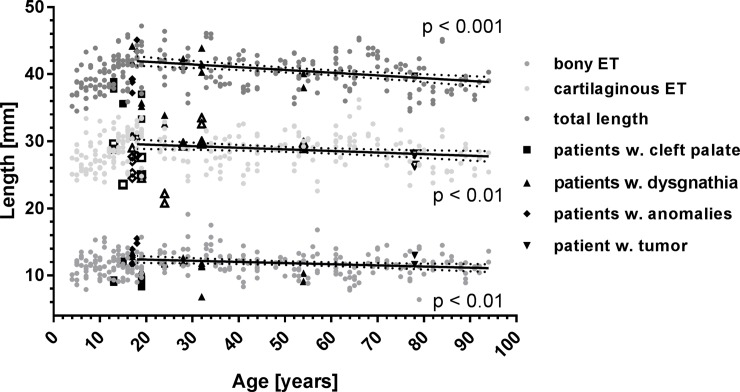
Lengths of cartilaginous and bony parts of the ET of all patients together with the total length of the ET.Additionally indicated are values for patients with pre-existing conditions such as cleft palate (□), dysgnathia (△), anomalies (◇), or a tumor (▽). Open symbols refer to cartilaginous parts whereas filled symbols belong to bony parts and the entire ET. Also provided are best linear fits for all adult patients with normal conditions, their 95% confidence intervals and p-values. The slopes of the linear fits are different from zero for all compartments indicating a reduction in length with higher age.